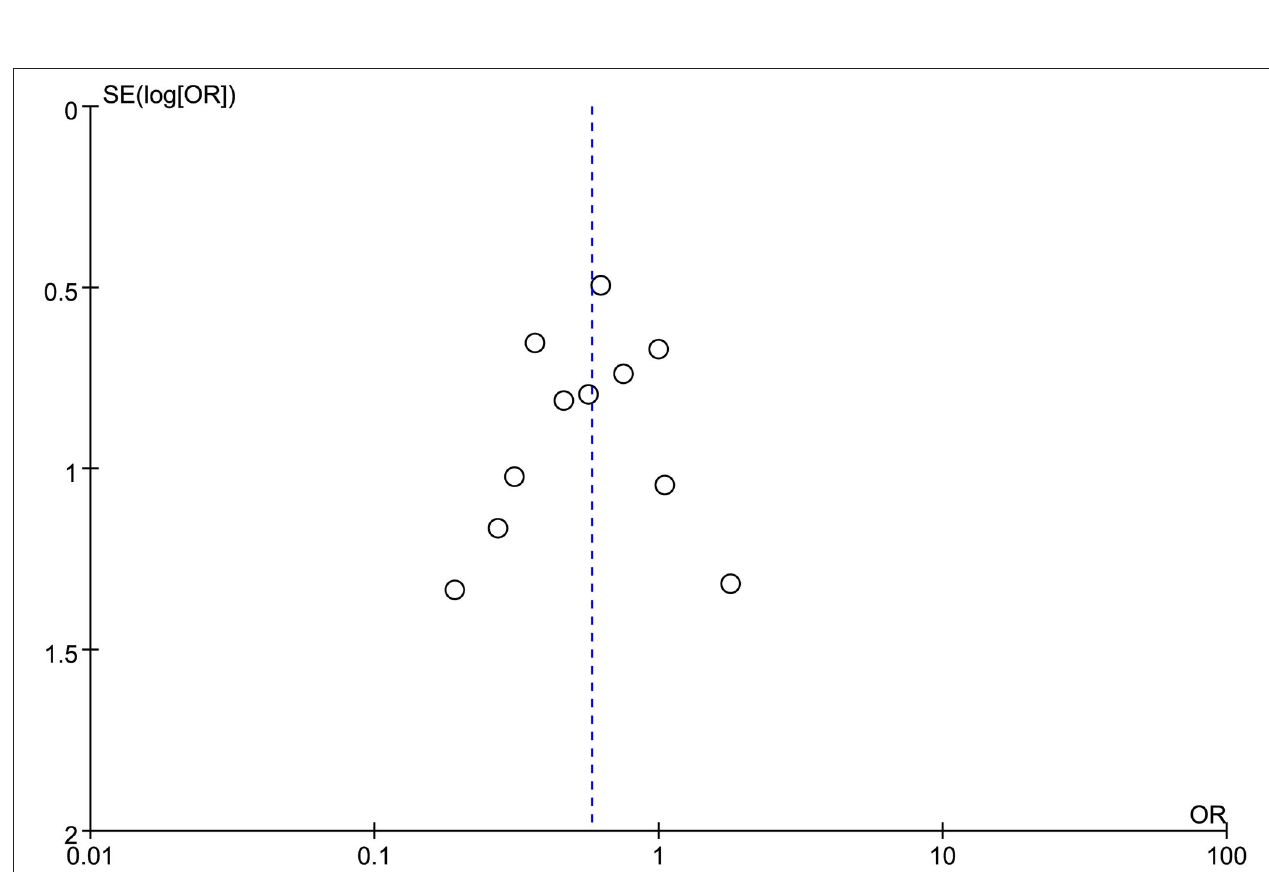
FIGURE 10 | Funnel plot of early adverse events between EUS-CDS and EUS-HGS.